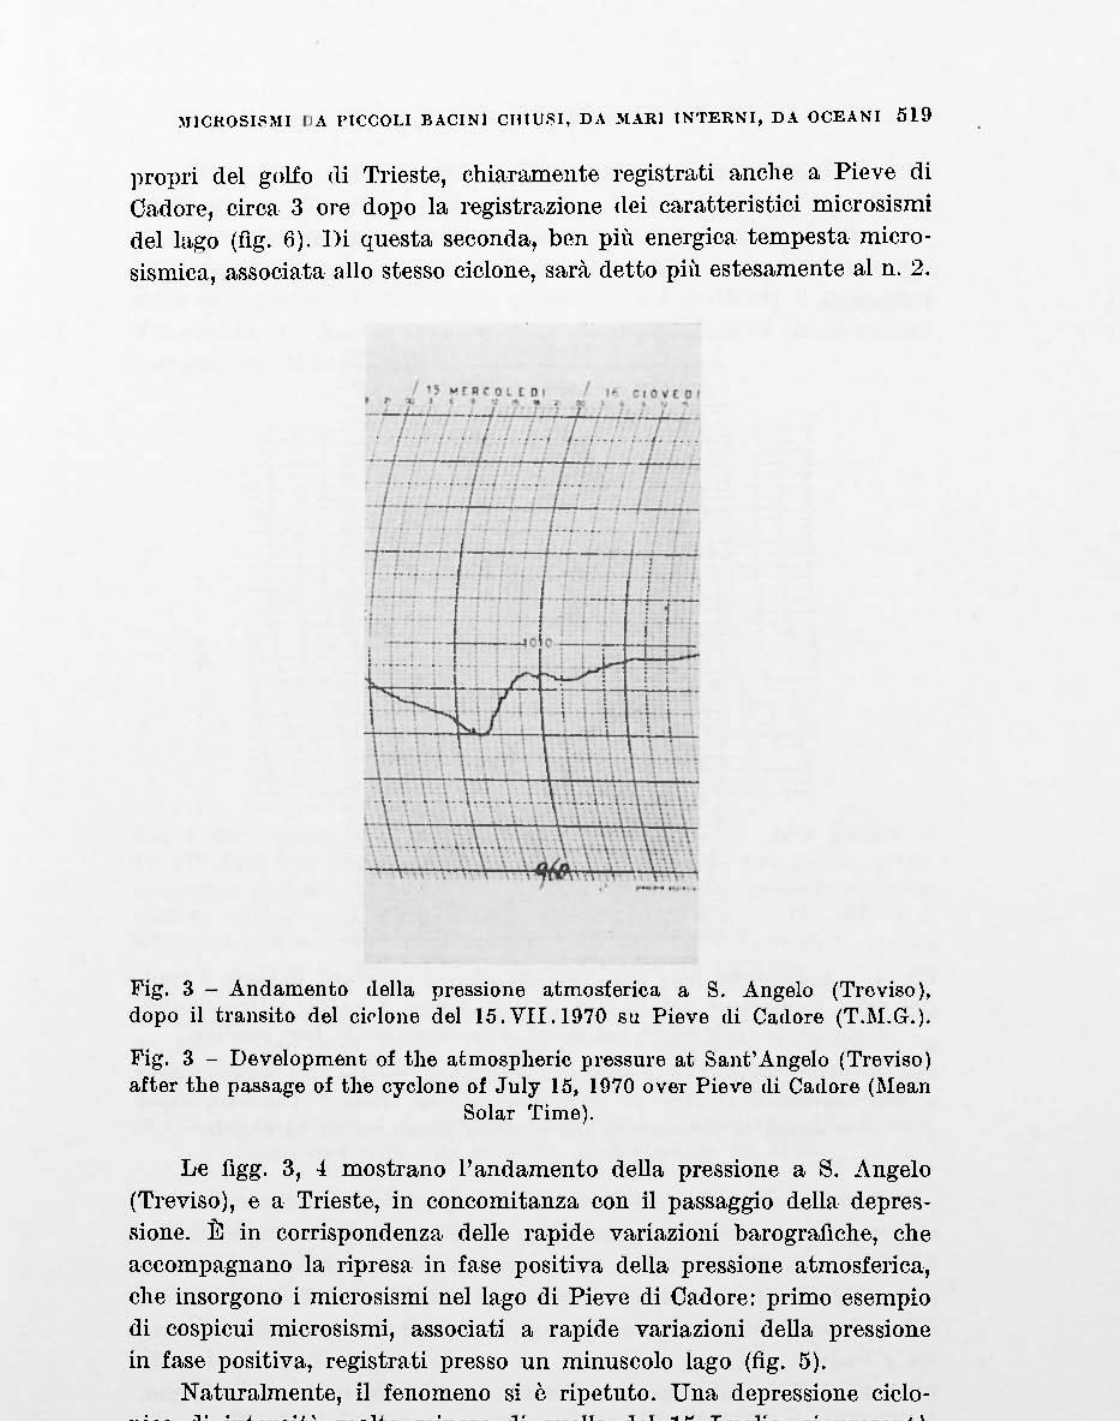
Fig. 3 - Andamento llella pressione atmosferica a S. Angelo (Treviso), dopo il transito del cidone del 15.VII.1970 SlI Pieve Ili Callore (T.M.G.). Fig. 3 - Development of the atmospherie pressure at Sant'Angelo (Treviso) after tbe passage of the cyclone of July I;,), 1970 over Pieve Ili Callore (Mean SolaI'